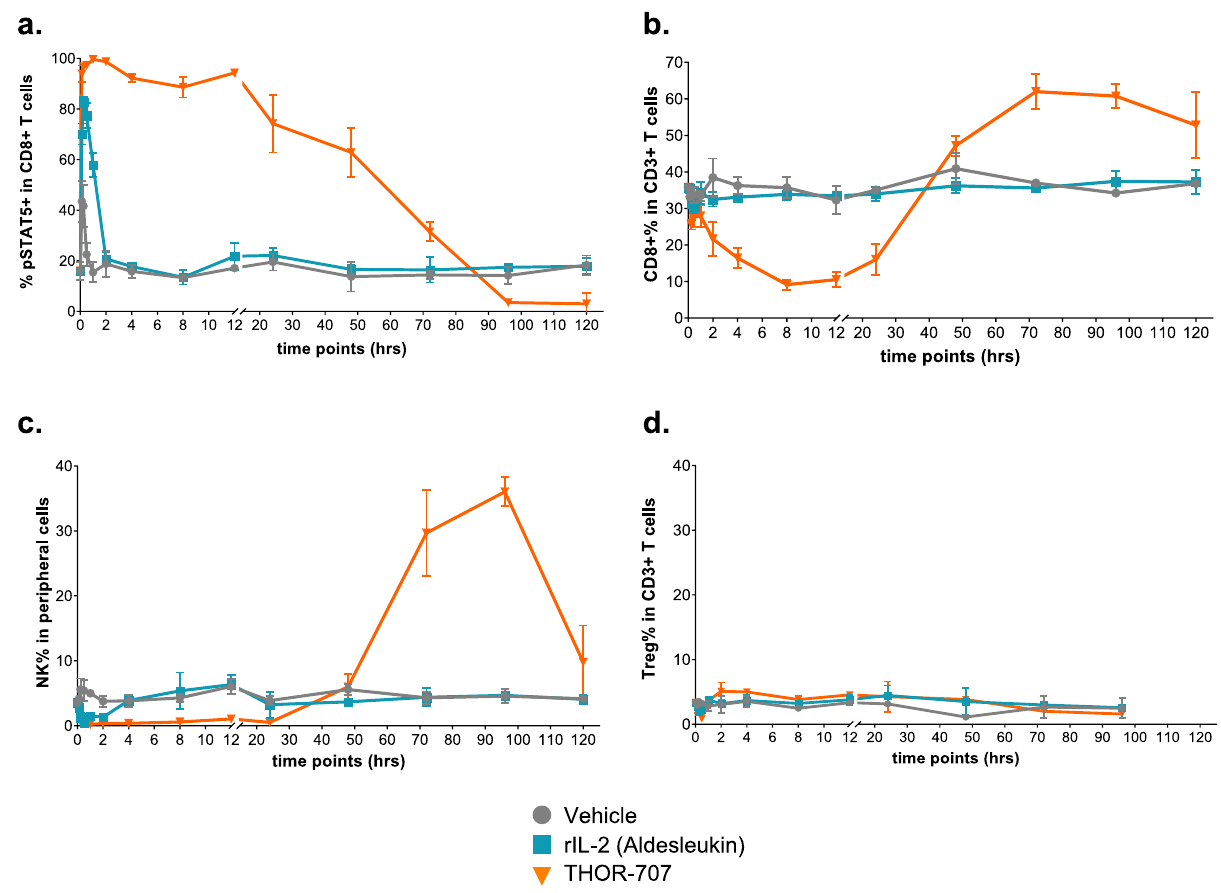
Fig. 4 A single dose of THOR-707 drives sustained pSTAT5 signaling, extravasation and proliferation of CD8 + T and NK cells without signi fi cant Treg expansion in naive mice. A single intravenous bolus dose of 0.3 mg/kg rhIL-2 or THOR-707 was administrated to naive mice and blood was drawn via cardiac puncture at the indicated time points. Immune cell identi fi cation and signaling were assessed by fl ow cytometry, each data point represents an average of 3 – 4 replicates at each time point ± standard deviation (SD). a Percentage peripheral blood CD8 + T cells that are pSTAT5 positive. b Percentage of peripheral CD3 + cells that are CD8 positive. c Percentage of singlets (peripheral blood cells sampled) that are NK cells. d Percentage of CD3 + cells that are CD4 + Treg cells ( n = 4 animals). Source data are provided as a Source Data fi